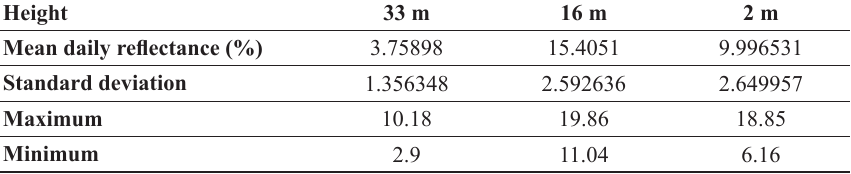
descriptive statistics of reflectance for the rainy season.